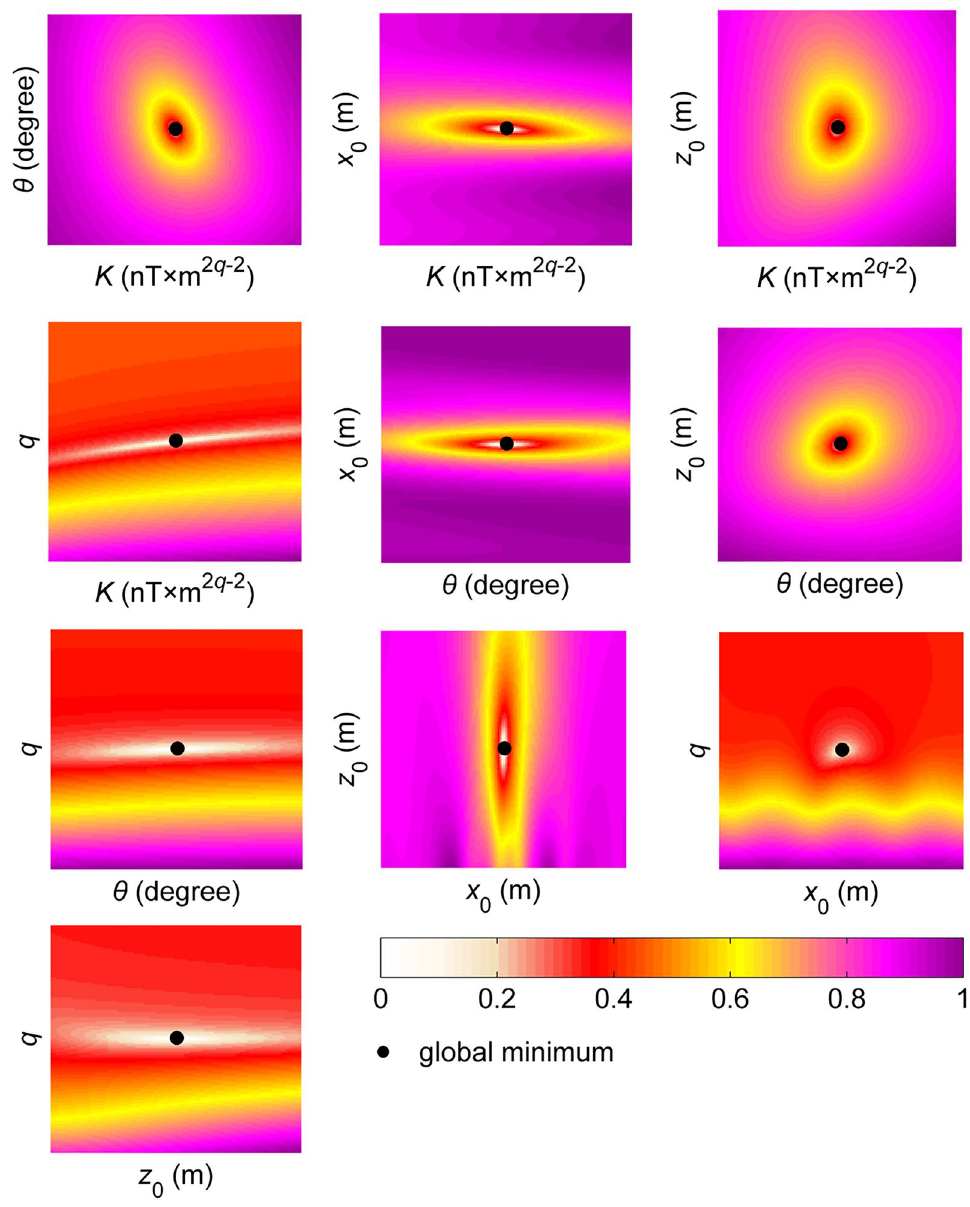
Figure 3. Modal analyses of the defined objective function for model parameter